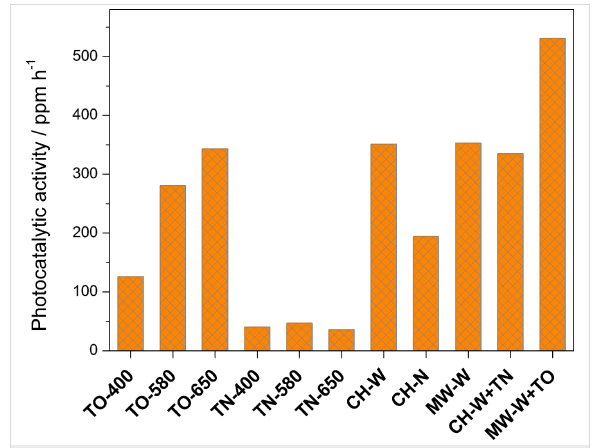
Figure 10: Comparison of the photocatalytic performance under UV–vis light for a series of TiO 2 nanoribbon